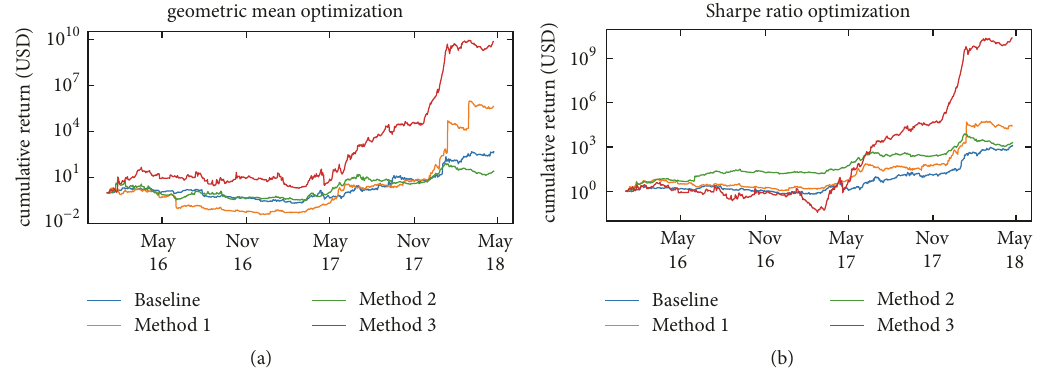
Figure 16: Cumulative returns in USD. The cumulative returns obtained under the Sharpe ratio optimisation (a) and the geometric mean optimisation (b) for the baseline (blue line), Method 1 (orange line), Method 2 (green line), and Method 3 (red line). Analyses are performed considering prices in